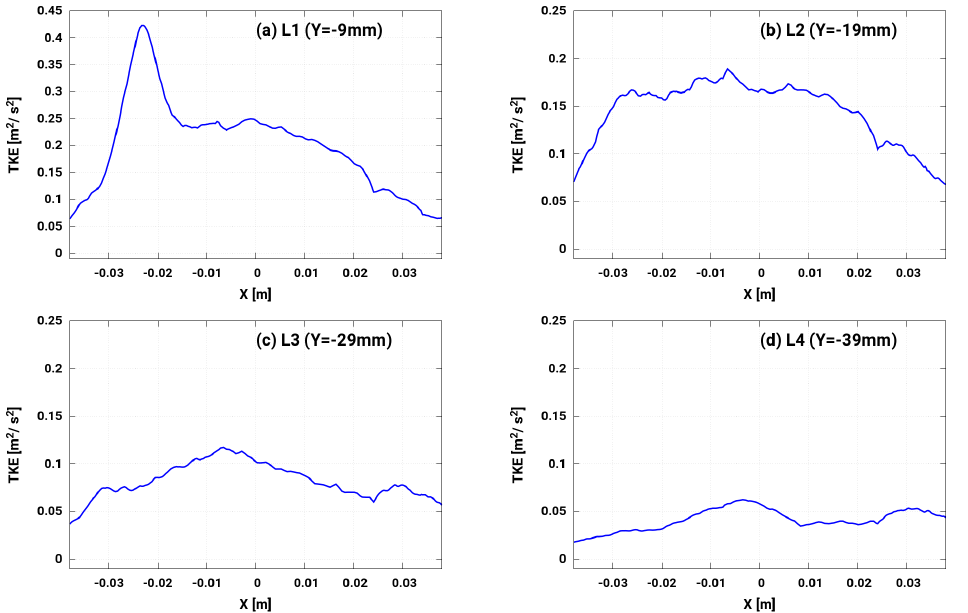
Figure 13. Turbulent kinetic energy profile at various locations (see Figure 10, bottom) on the middle plane at Z = 0 mm.